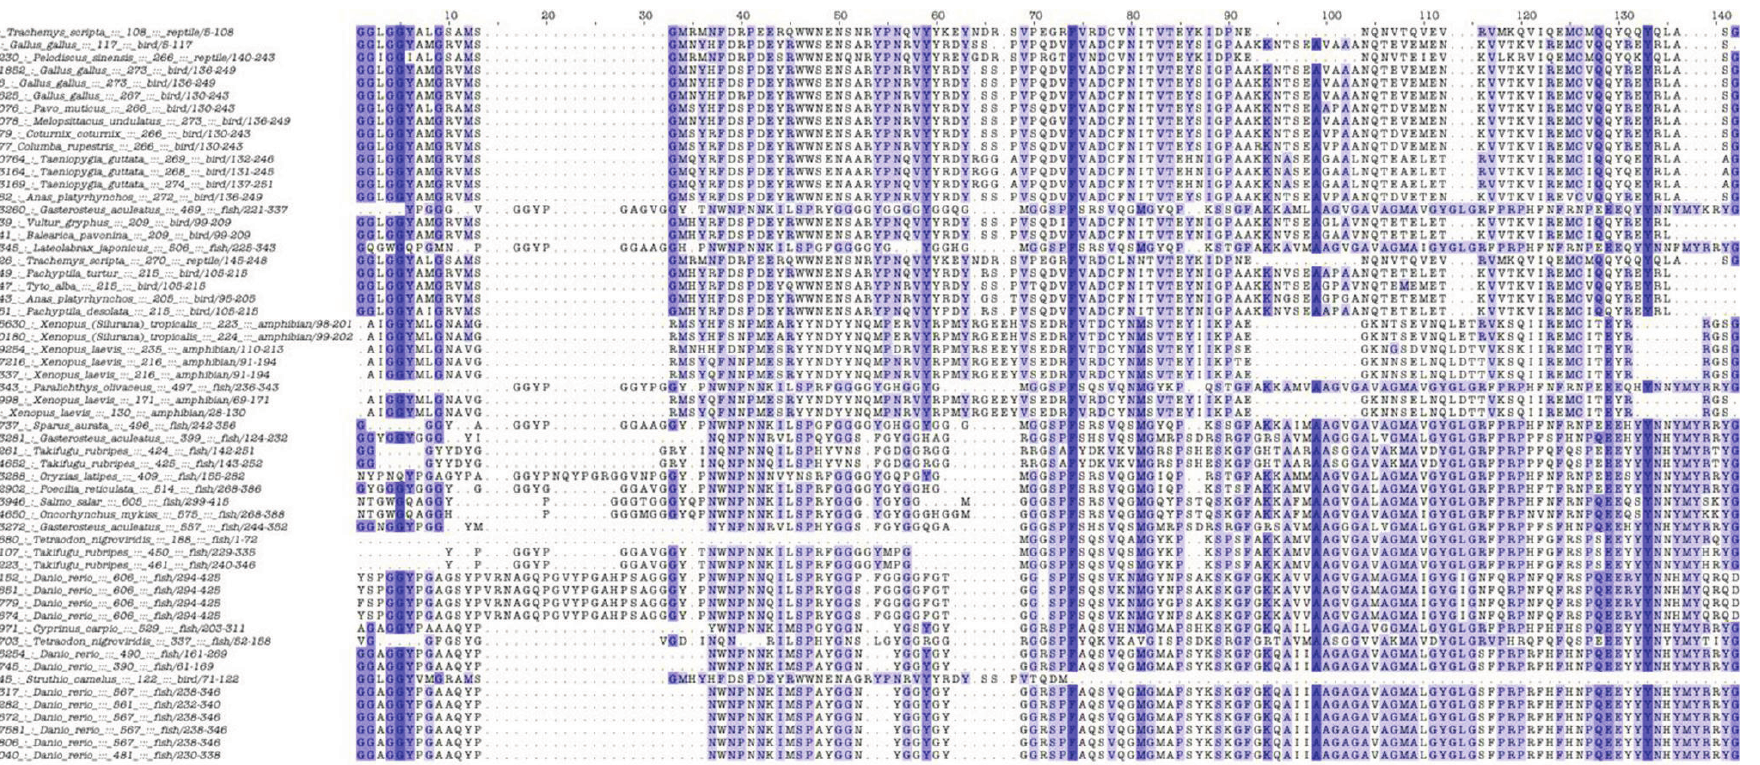
Figure 7. Alignment of the C -terminal region of 58 detected non-mammalian PrP sequences. The C -terminal domain of PrPs is shown, with identifiers, species names, total length, vertebrate taxon and sequence coordinates for each sequence ( left panel ). The full alignment is provided as Supplement 2 in FASTA format. Boxes signify sequence identity (darker color corresponds to more conserved positions). Note that the three sequences obtained from the PDB database, namely 1U5L ( Trachemys scripta , reptile), 1U3M ( Gallus gallus , bird) and 1XU0 ( Xenopus laevis , amphibian) correspond to proteins of known